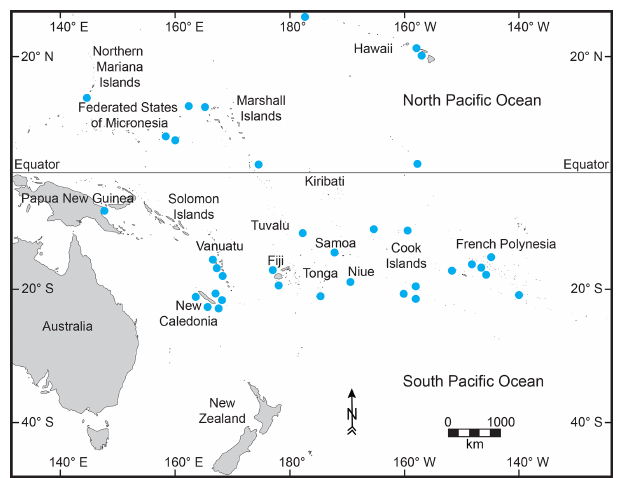
Figure 1. Map showing the tropical Pacific islands considered in this article (blue